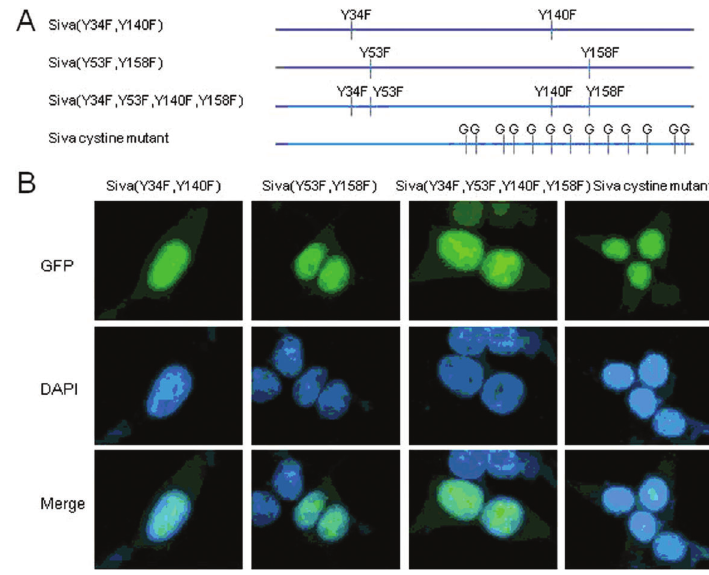
Figure 4. Role of tyrosine and cysteine substitu- tion in the subcellular distribution of Siva-1. Y34F and Y140F, Y53F and Y158F, quadruple mutant, and cysteine mutant were transfected into 293T cells and nuclei were counterstained with DAPI (blue). GFP: green fluorescent